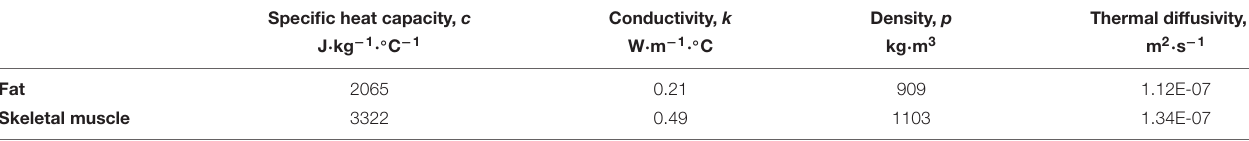
TABLE 3 | Physical properties of fat and skeletal muscle. Specific heat capacity, c Conductivity, k Density,